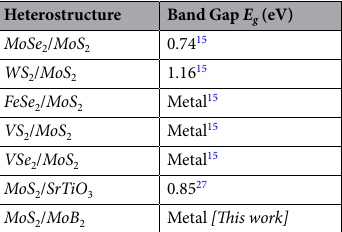
5 Scientific REPORTS | (2018) 8:14444 | DOI:10.1038/s41598-018-32850-z